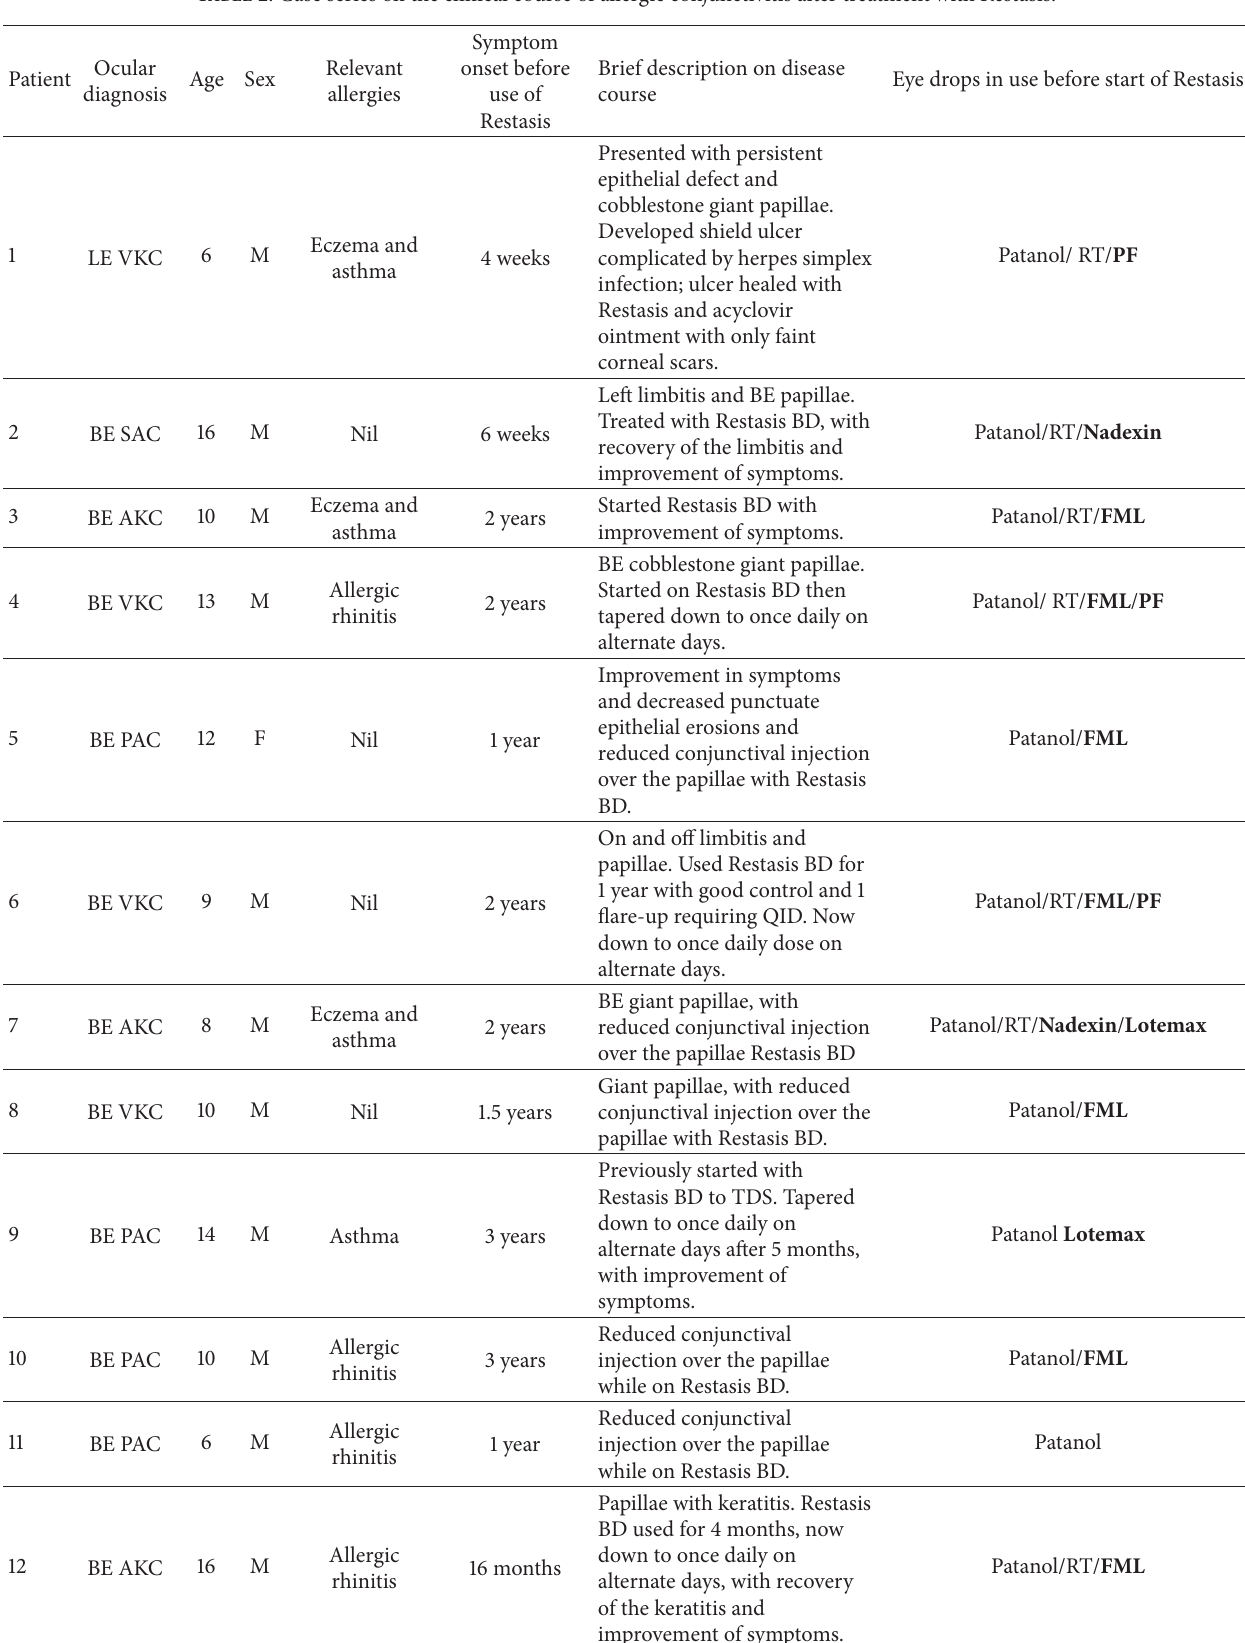
Table 2: Case series on the clinical course of allergic conjunctivitis after treatment with Restasis. Ocular Patient Age diagnosis